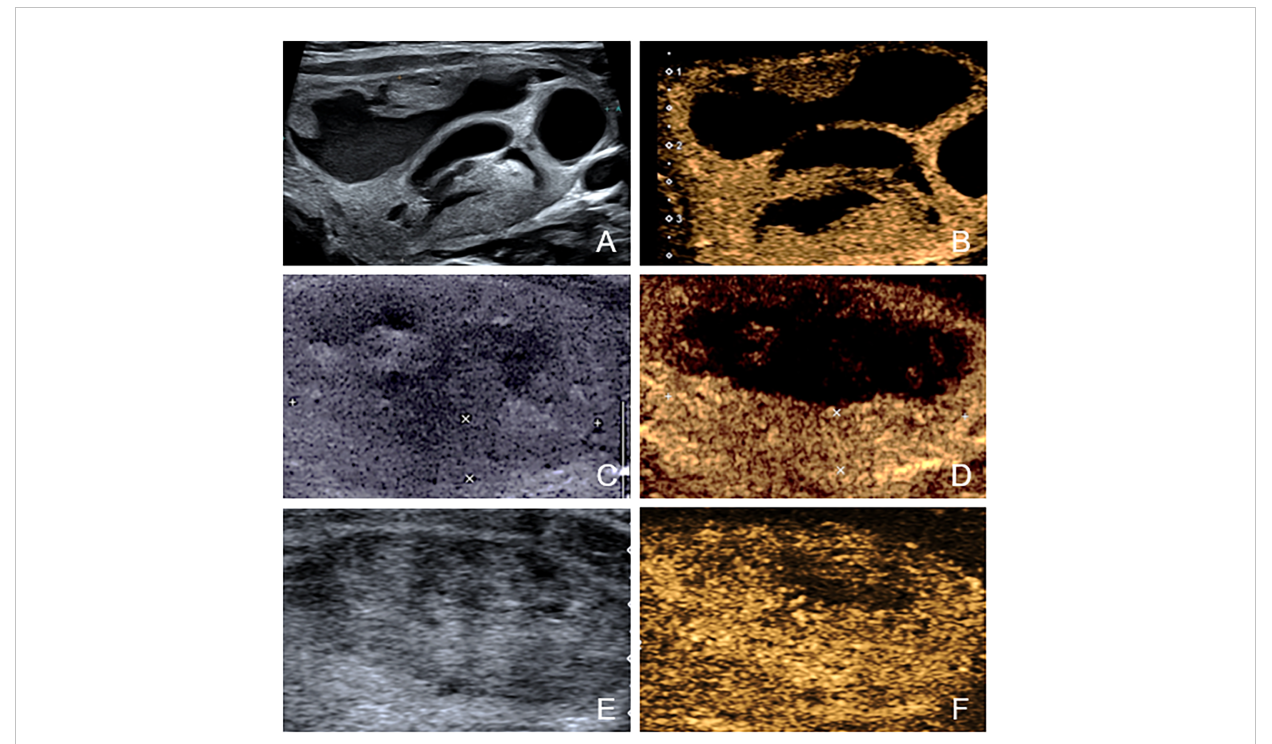
FIGURE 3 The US and CEUS feature of a case in residue group — a 34-year-old female. (A, B) Before ablation, the initial volume of the target nodule was 21.21 ml. There was obvious septum in the nodule. Her residue rate according to the nomogram was 58.5%. (C, D) At one-month follow-up, an enhanced area (about 3.0cm×0.6cm) was observed at the ablative margin under CEUS. (E, F) At four-month follow-up, the volume was 12.90ml, and VRR was